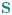
Caffeine reduced burst suppression caused by deep anesthesia (≥ 1.2% Isoflurane).In A, a representative raw EEGs from a rat in saline and caffeine experiments. Isoflurane at 2% caused significant burst suppression. Caffeine at 37.5 mg/kg reduced the burst suppression caused by deep anesthesia. Caffeine also led to the shift to high frequency in EGG at a higher concentration of isoflurane. The EEG patterns before RORR were similar in both saline and caffeine experiments. The horizontal lines represent examples of suppression. The small arrows (↓) point to 60 cycles on the EEG. The horizontal lines represent examples of suppression. In B, burst suppression ratio (BSR) was calculated. Each epoch length was 1 minute. BSR of 1 indicated no electrical activity while a ratio of 0 showed no suppression. The graph started 2 minutes before caffeine or saline injection and ended after the burst suppression disappeared. The chart represents an averaged number of 6 rats in both saline and caffeine (37.5 mg/kg) experiments. Caffeine reduced the BSR after the injection. The burst suppression was also reduced as isoflurane was dialed down in saline experiments. The burst suppression ratio was calculated with the formula, BSR = (total time of suppression/epoch length) x 100%. Two members of our group performed this calculation independently. ↓ represents the time of saline (S) or caffeine (C) injection. Comparisons were made at each time point between saline and caffeine experiments. A repeated-measures ANOVA model was fit with condition (saline vs caffeine) and time as repeated factors. There was evidence for a time by condition interaction (Green-Geisser adjusted p = 0.0003). Subsequently saline versus caffeine comparisons (Bonerroni adjusted) gave the following: no significant difference from times (t) of 2 min or less; t = 3 (**p<0.01), t = 4 (**p<0.01), t = 5 (****p<0.0001), t = 6 (***p<0.001), t = 7 (*p<0.05) and no significant difference from 8 to 19 min (n = 6).